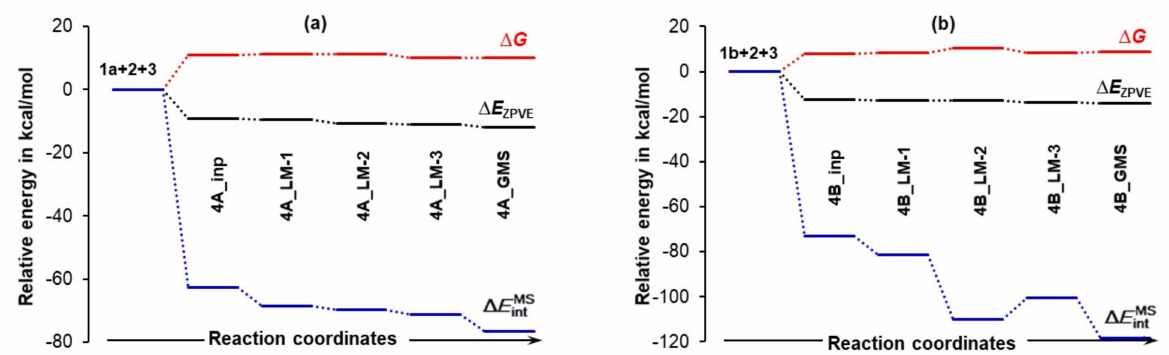
Figure 7. Relative to the energy of separate molecules of 1 (proline, either 1a in part ( a ) or 1b in part ( b )), 2 (acetone), and 3 (DMSO solvent molecule), and energy changes ( ∆ E ZPVE , ∆ G and ∆ E MS computed at the 6-311++G(d,p)/GD3 level in DMSO for the 3-MCs containing 1a shown in Figures S1–S4 in Part 3 of the Supplementary Materials and 1b shown in Figure